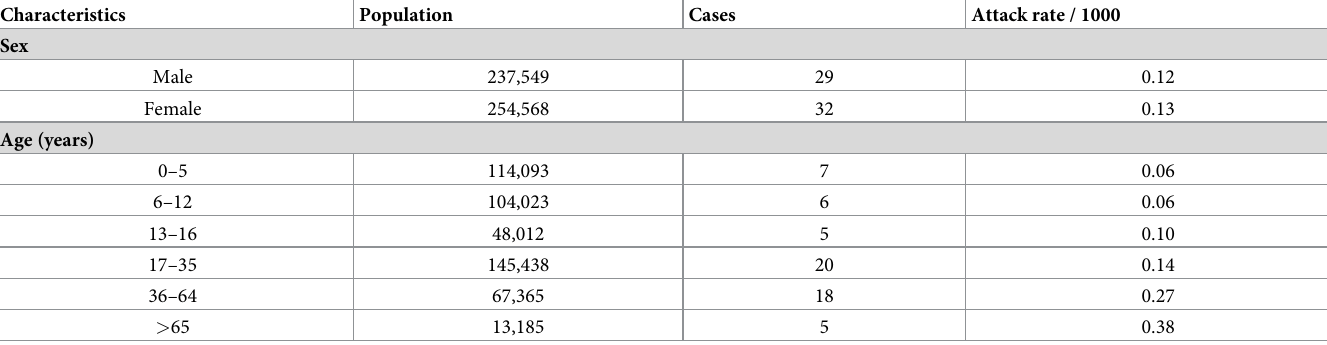
Table 1. Attack rate by sex and age during a gastrointestinal anthrax outbreak: Isingiro, Uganda, August 2017. Characteristics